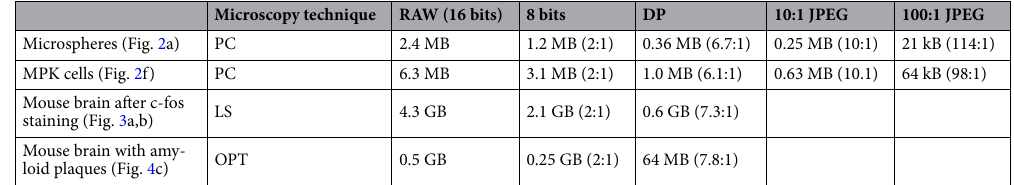
Table 3. Size of the datasets used for the segmentation tests performed in this